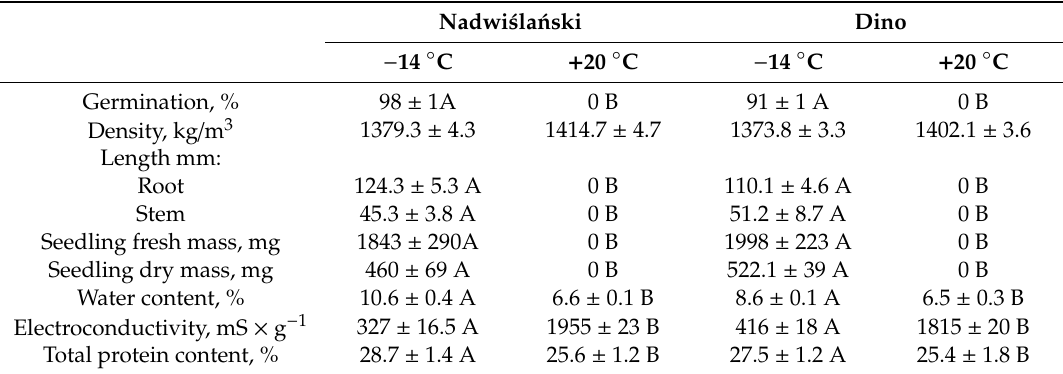
Table 1. Seed viability, radicle and stem length, fresh and dry seedling mass, water content and seed